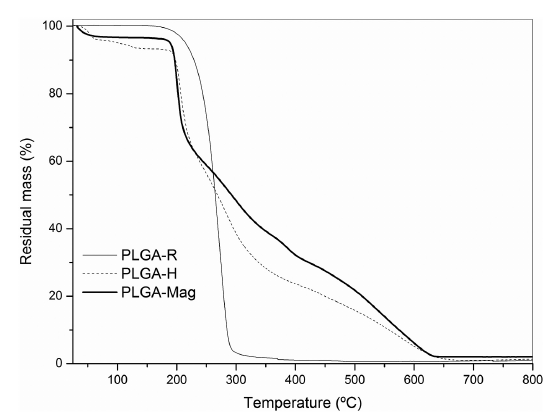
Figure 2. TG curves for PLGA-R, PLGA-H and PLGA-Mag. N rate 50.00 mL.min –1 , heating rate of 2.5 °C.min –1